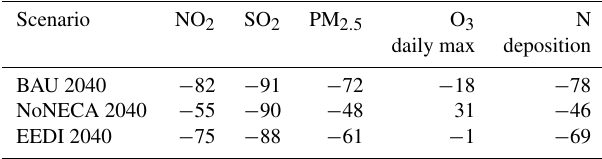
Table 6. Summary of ship contribution changes in future scenarios. Changes (in percent) in spatial average of the ship contributions for all future scenarios compared to the present day (simulations with all emissions): annual means of NO 2 , SO 2 , PM 2 . 5 and the daily maximum O 3 within the 4km resolution area (CD04 grid domains) and annual sum of nitrogen deposition to